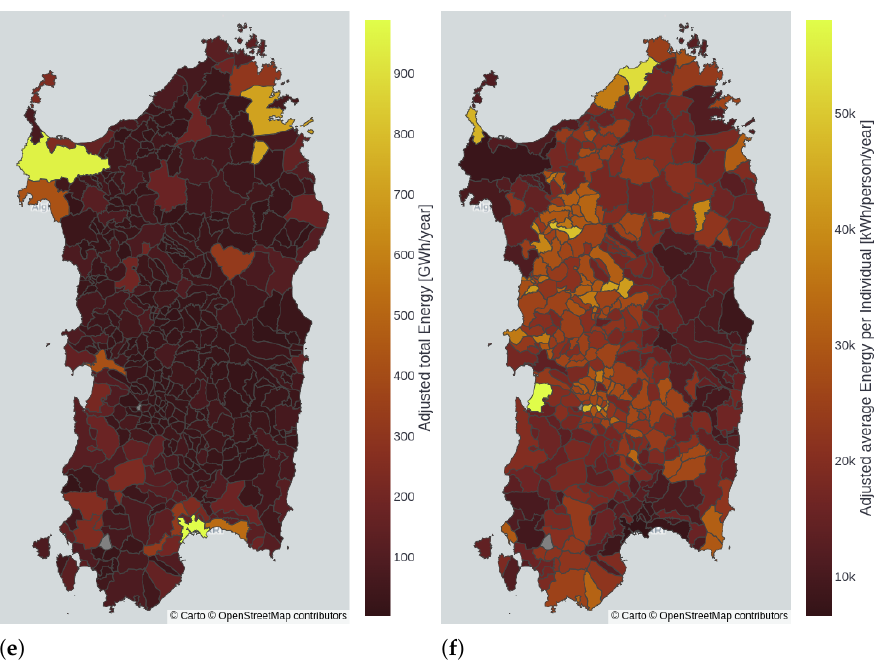
Figure 9. ( a ) Total yearly photovoltaic potential and ( b ) average yearly photovoltaic potential per resident for the municipalities in